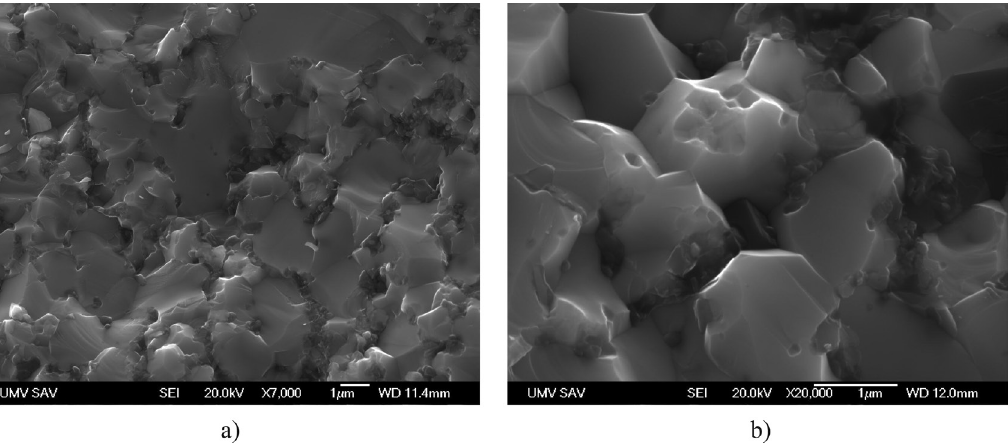
Fig. 7: Fracture of the composite with 10% nano SiC particles broken at room temperature after finishing creep at 1473 K and 100 MPa: a) transcrystalline brittle fracture and b) detail of the grain boundaries with clusters of the SiC nano